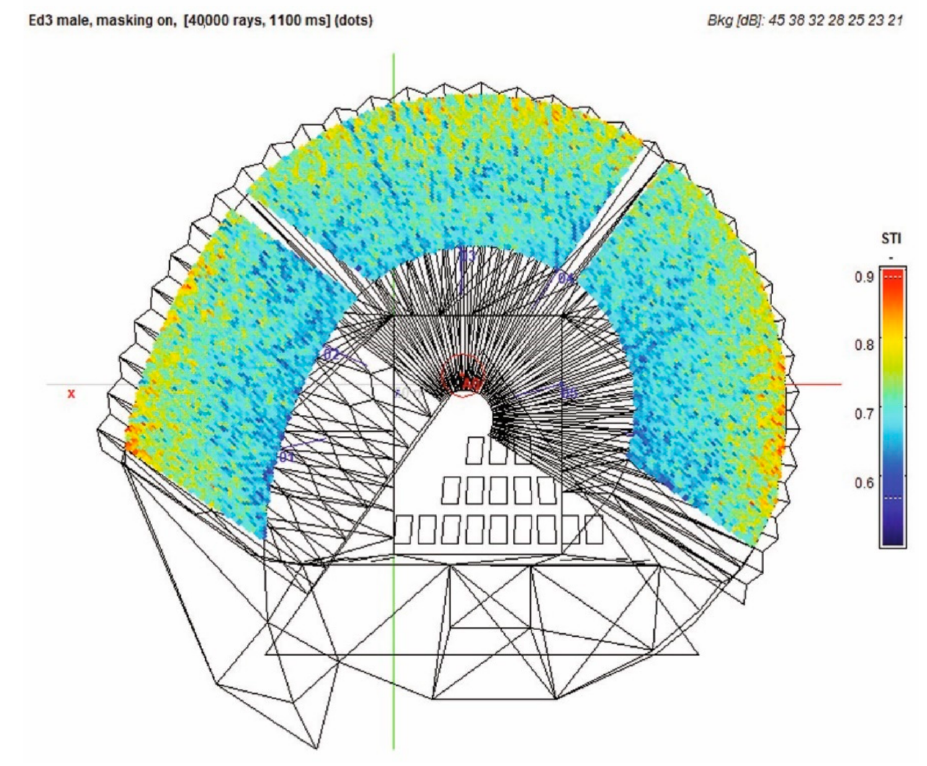
Figure 13. Audience acoustics analysis of sound distribution. Reprinted from ref.